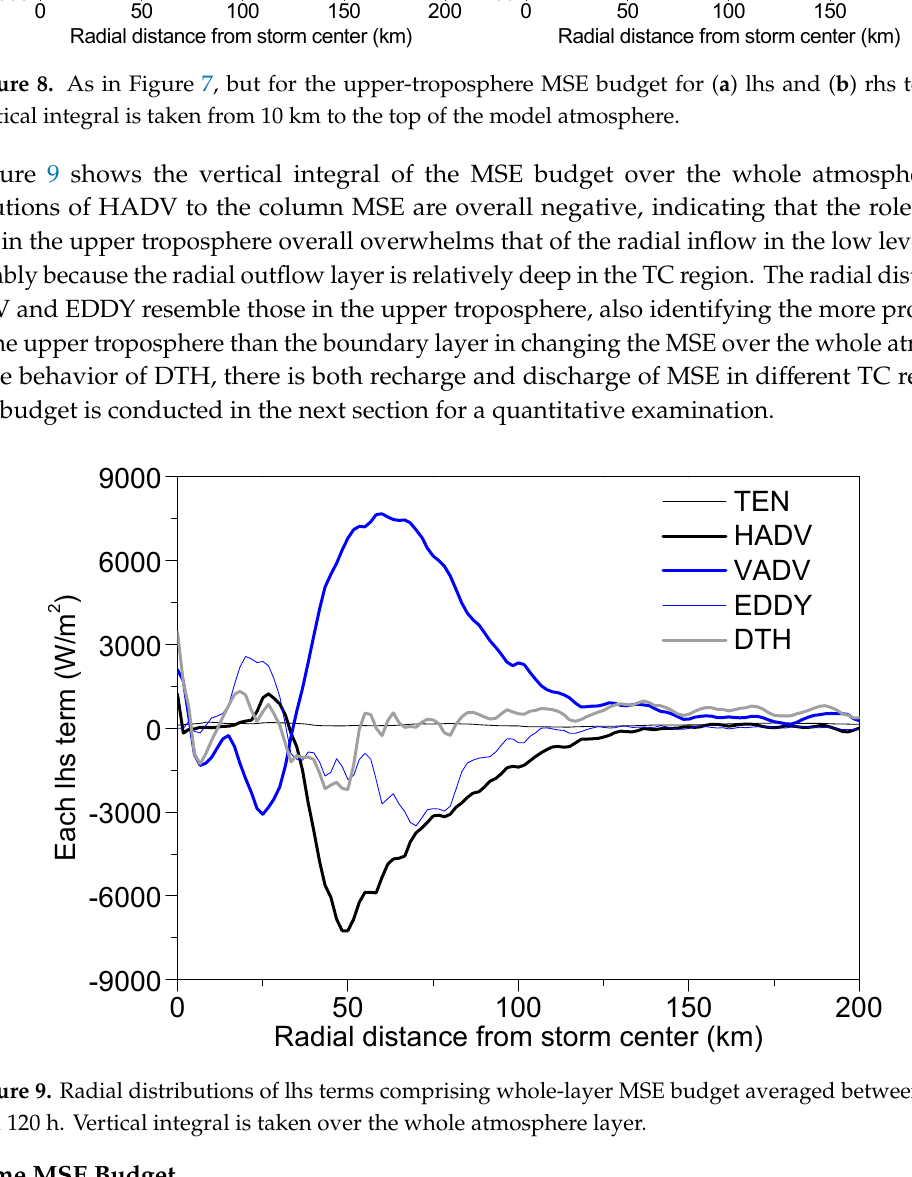
Figure 9. Radial distributions of lhs terms comprising whole-layer MSE budget averaged between 108 and 120 h. Vertical integral is taken over the whole atmosphere layer.